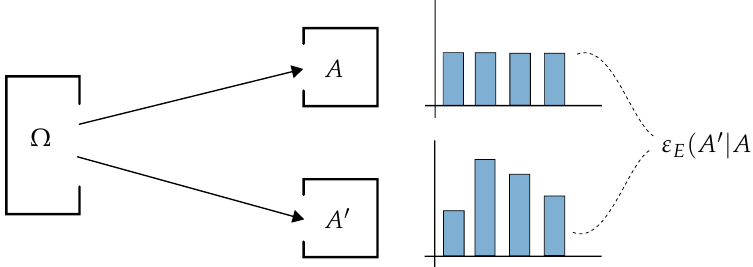
Figure 5. The entangled reference error ε E ( A (cid:48) | A ) is a single expectation value, namely of the cost c ( x , y ) , where y is the output of A T and x the output of A (cid:48) . Like the other error quantities, this expectation vanishes iff A (cid:48) = A